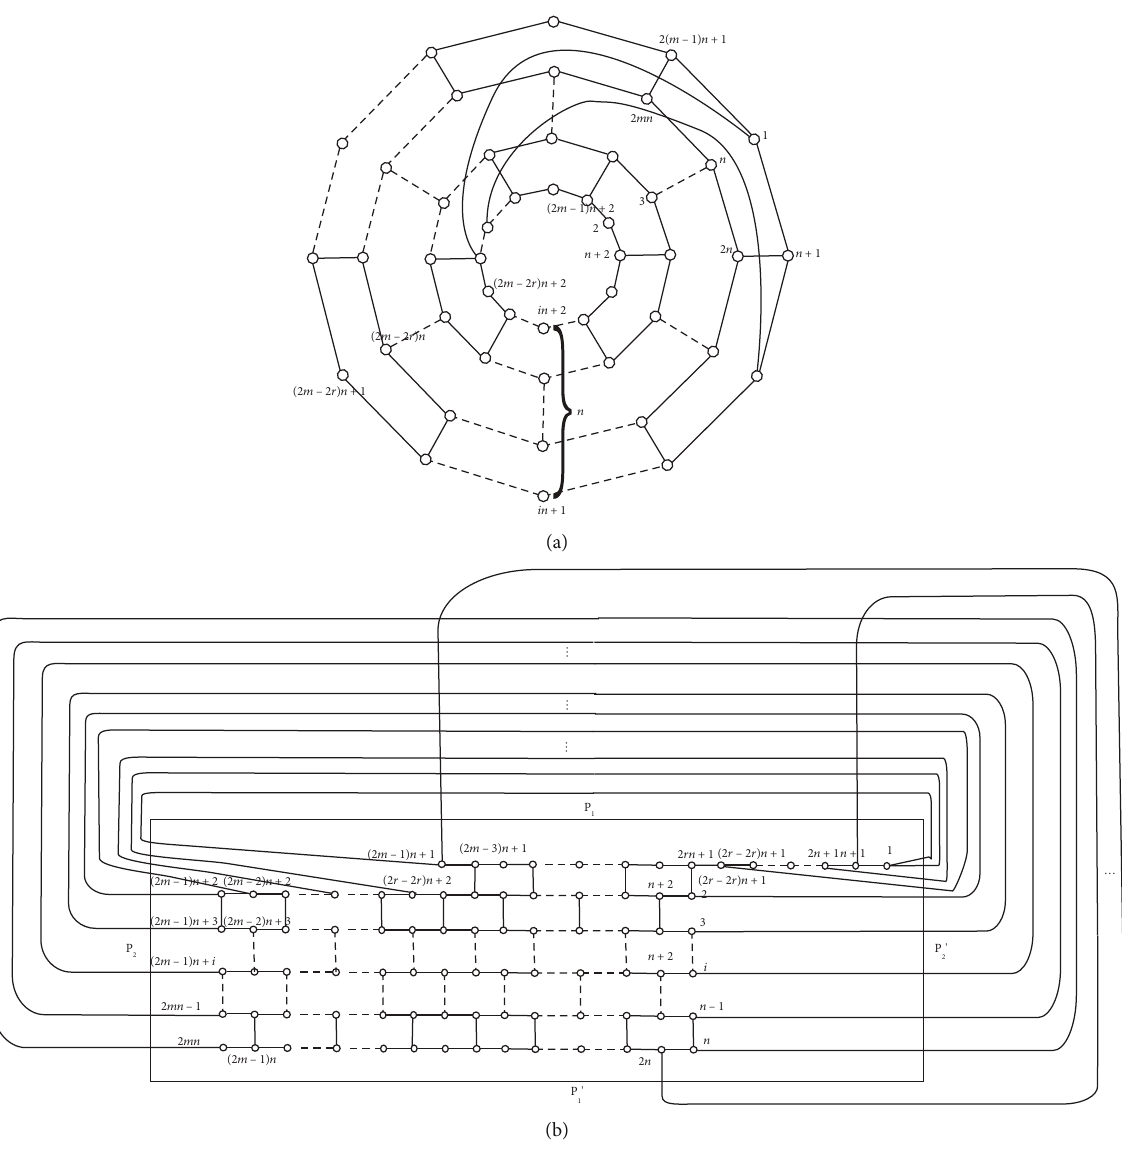
Figure 4: H embedded on a torus and a corresponding plane model, where n is 2 m , n , r